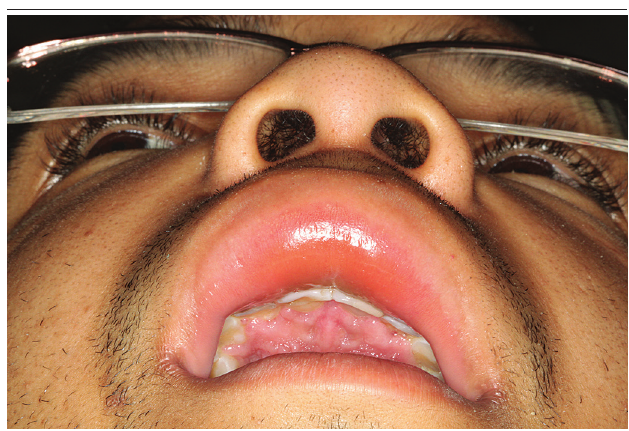
figurE 15 − Swollen lip of patient of case 2 due to postoperative